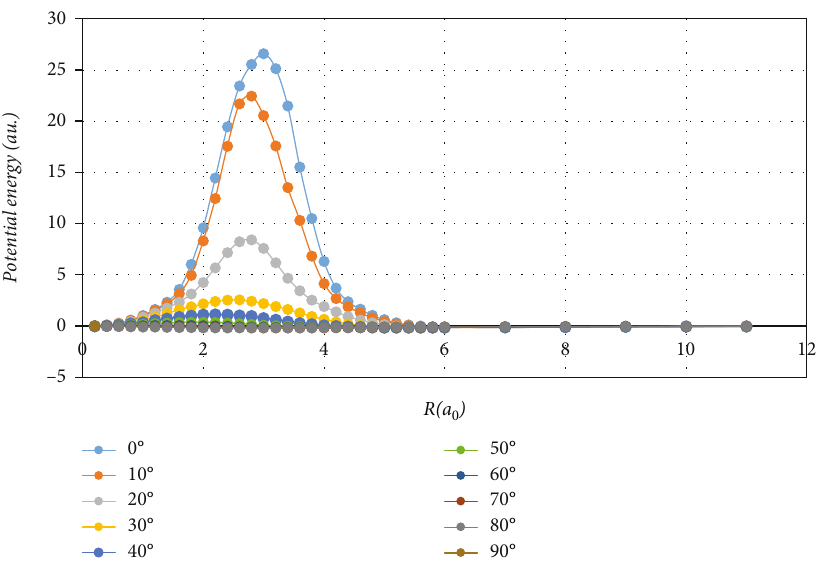
Figure 2: The analysis of the peak from 0 to 90 degrees for the potential curve.